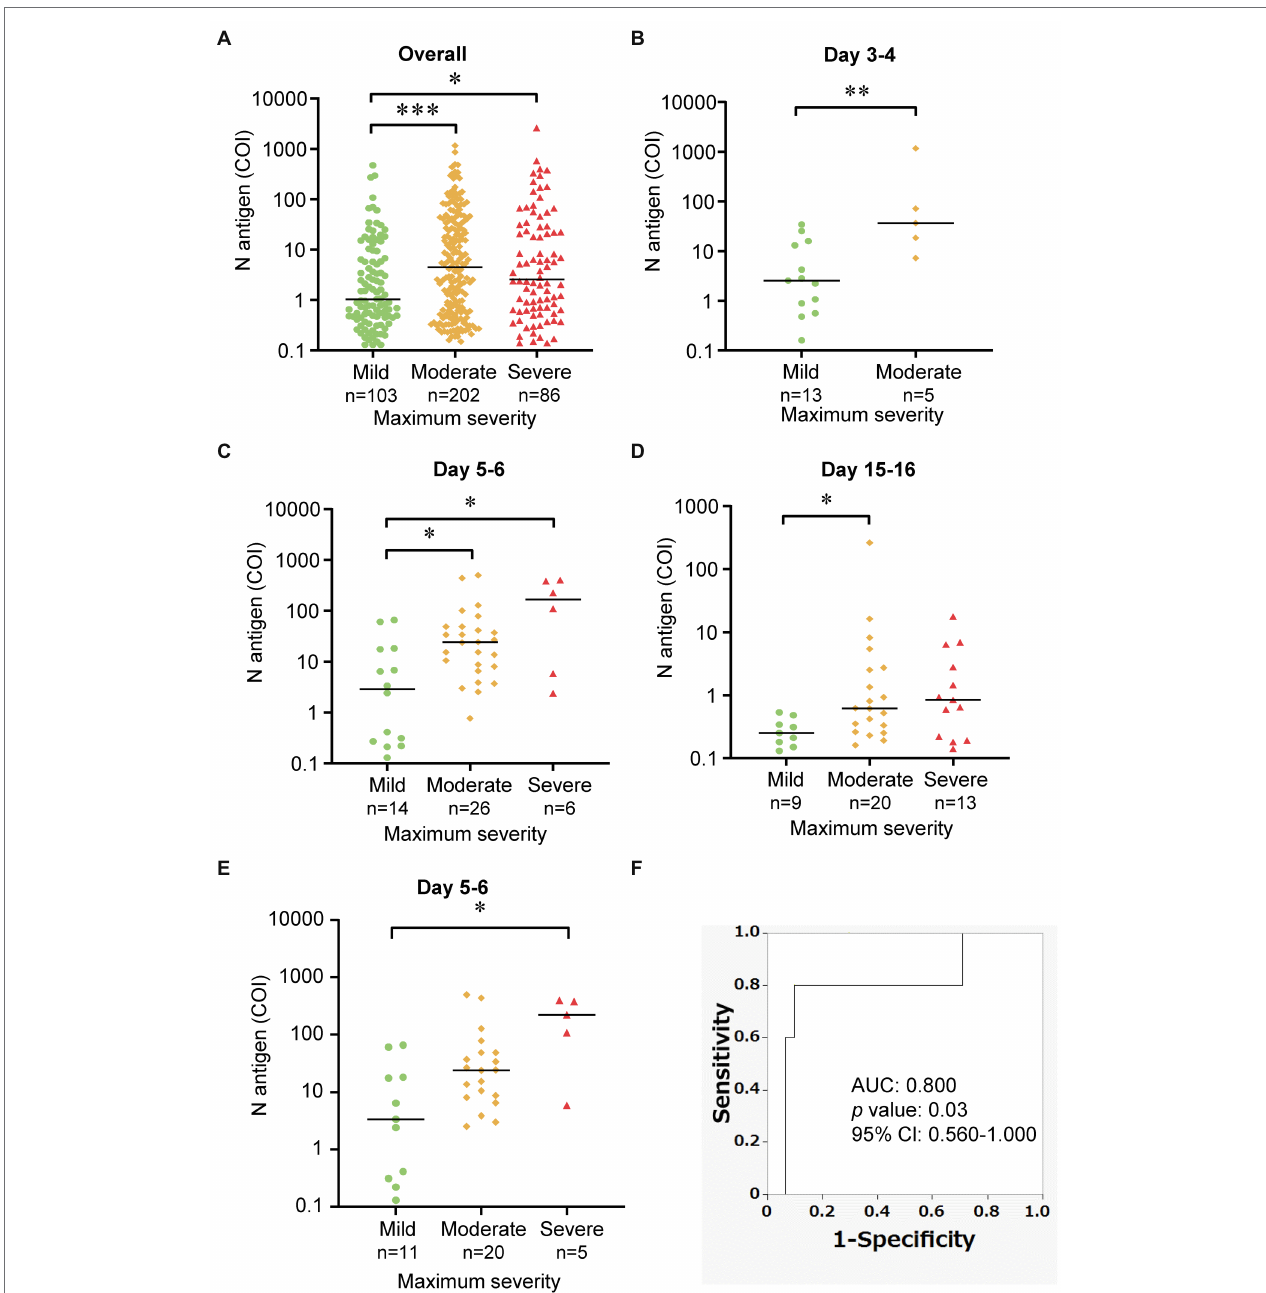
FIGURE 3 | Comparison of the serum N antigen levels among the three maximum severity groups. These dot plots show a comparison of the serum N antigen levels among the mild, moderate and severe group (A) overall, (B–D) at various time-points after symptom onset, and (E) using one time-point serum N antigen levels from individual patients at day 5–6. The bars show the median levels at each time-point. (F) We performed ROC analysis to discriminate the group with severe COVID-19 from other groups. * p < 0.05; ** p < 0.01; *** p <